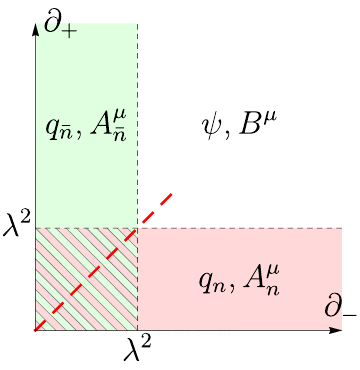
Figure 1 . Domains of fields in the plane of light-cone momenta components according to eq. (2.12),